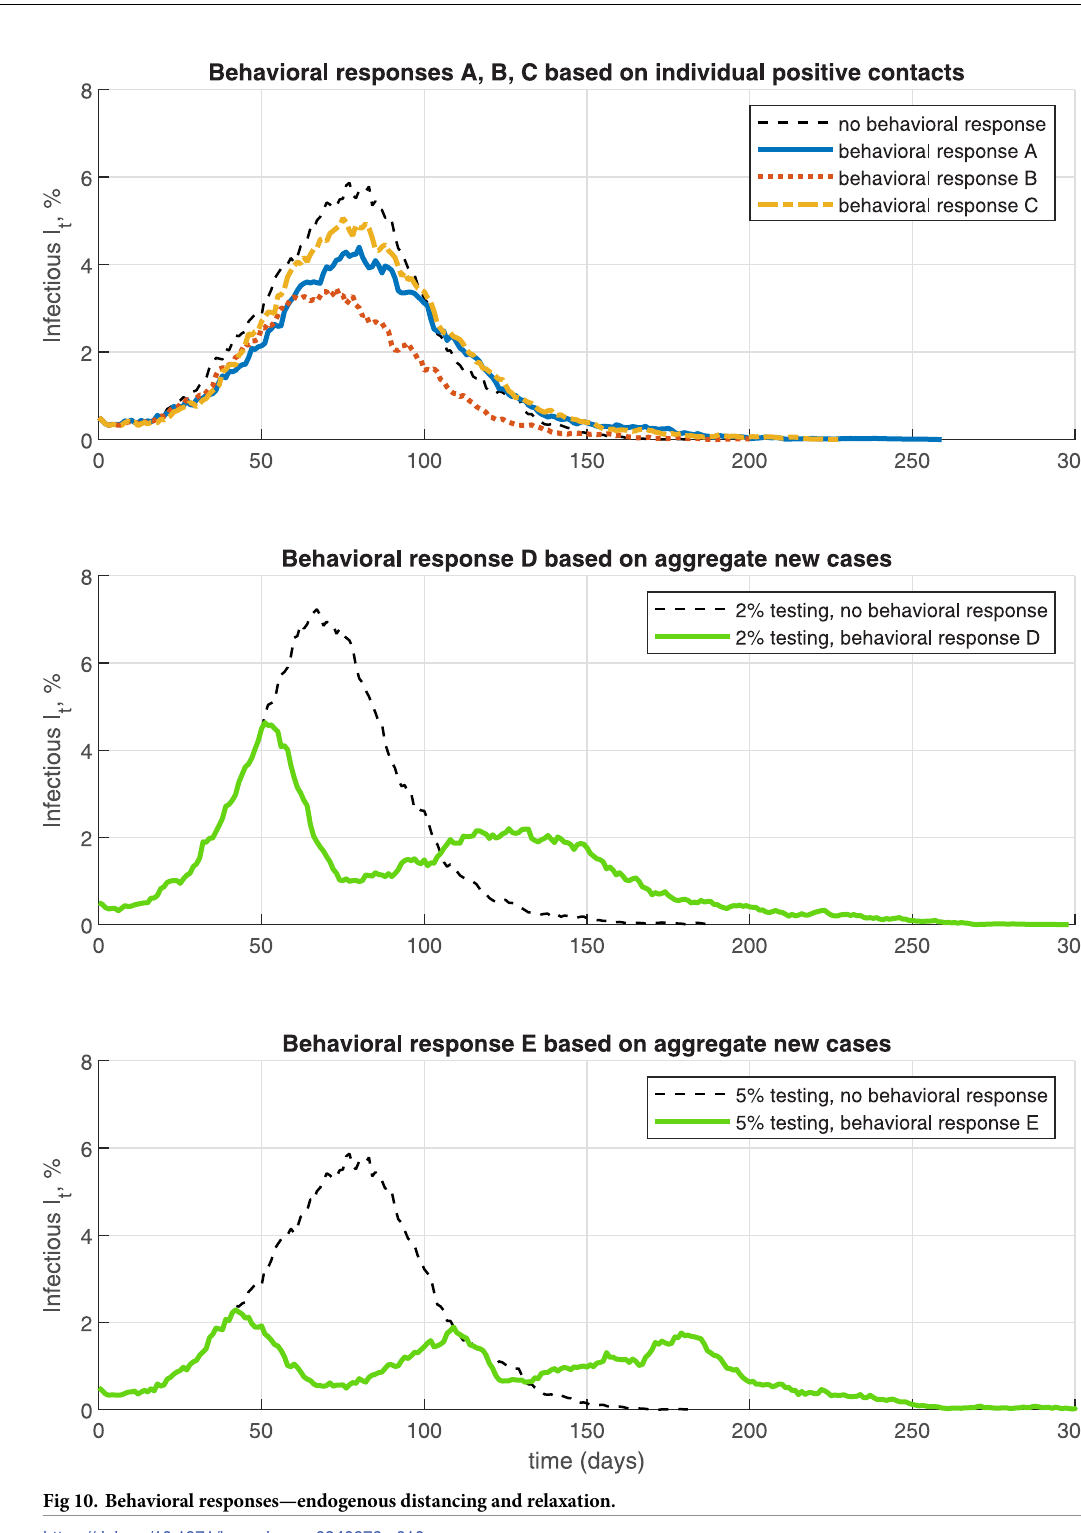
PLOS ONE | https://doi.org/10.1371/journal.pone.0240878 October 29,